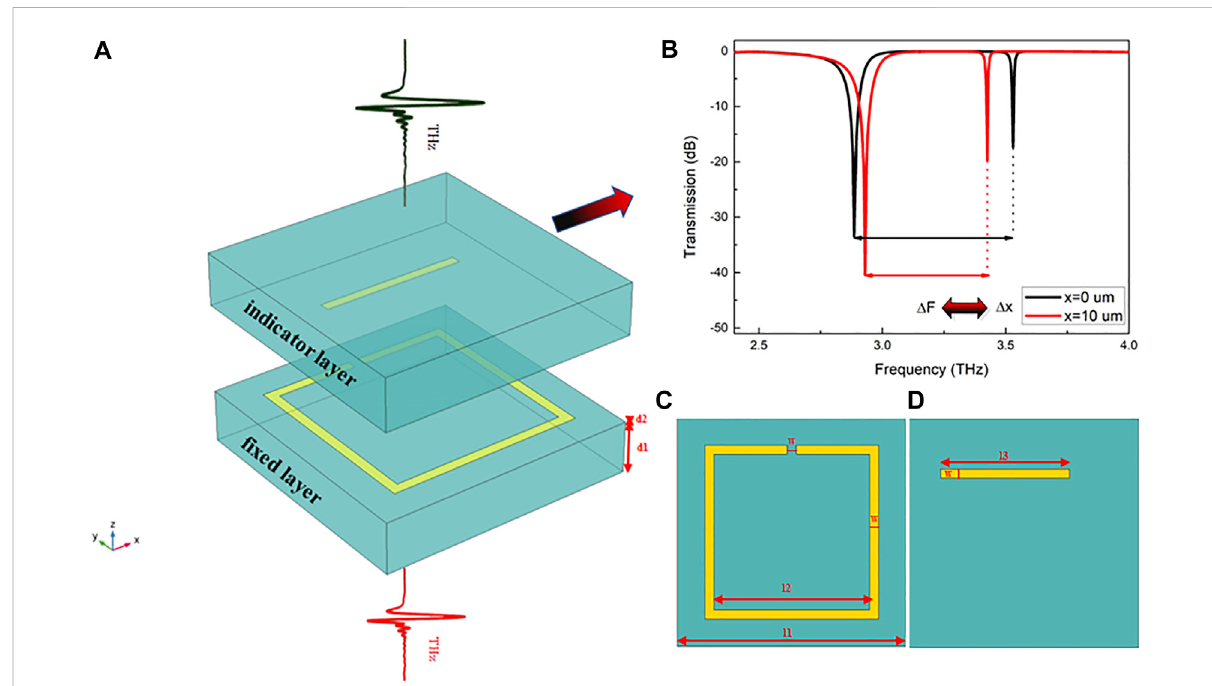
FIGURE 1 The schematicdiagram of theproposedterahertz (THz) displacement sensor. (A) The schematic diagram of the proposed THz-DS unit. (B) The schematicdiagramofthexdisplacementcorrespondstothetroughmovementoftheTHztransmissionspectrum. (C) Thetopviewofthe fi xedlayer of the proposed THz-DS. (D) The top view of the indicator layer of the proposed THz-DS.